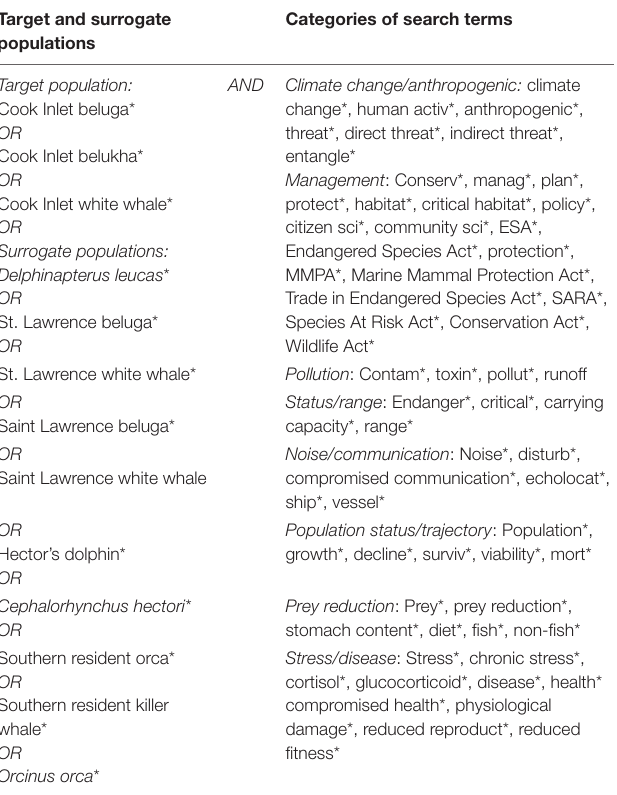
TABLE 2 | Search terms used for a systematic review of threats to Cook Inlet belugas, and surrogate species (St. Lawrence beluga, Hector’s dolphins, and southern resident killer